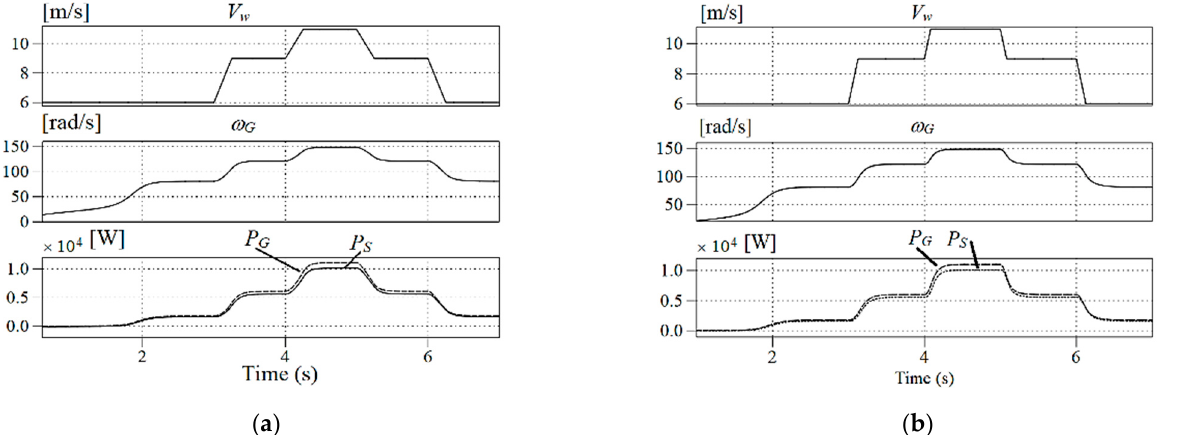
Figure 10. Assumed changes in wind speed V w ( a ) 12, 8, − 8, − 12 [m/s 2 ]; ( b ) 24, 24, − 24 − 24 [m/s 2 ] and corresponding changes in angular velocity ω G , generator power P G , and power grid P S.